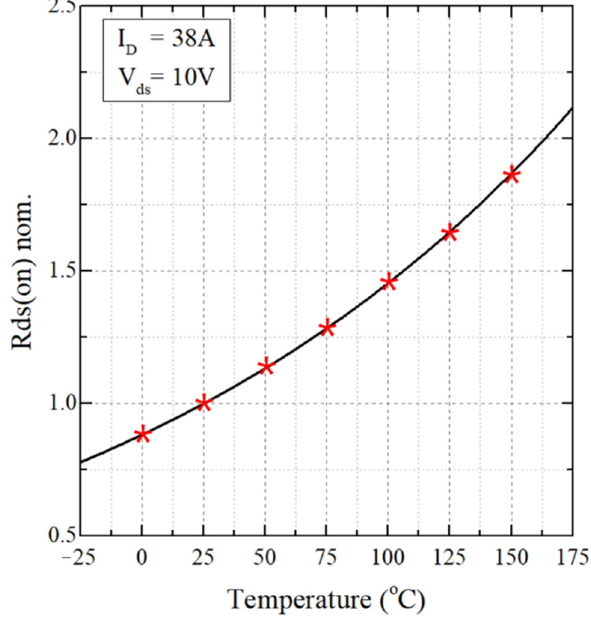
Figure 7. Characteristics of Rds(on) with respect to temperature of MOSFET junction.